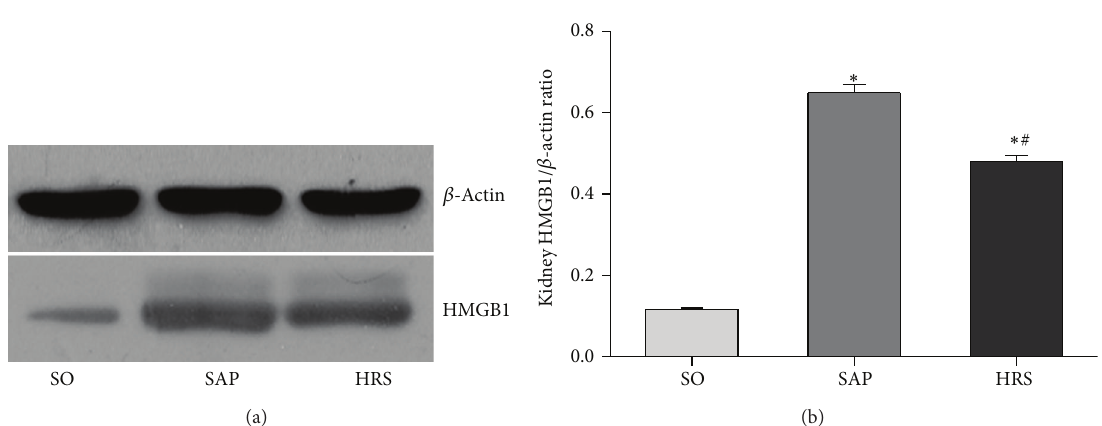
Figure 9: Western blotting for measuring the expression of HMGB1 by using extract of renal total proteins at 24 hours. (a) Level of HMGB1 and (b) densitometric analysis of the bands for the ratio of HMGB1/ 𝛽 -actin. Results are expressed as mean (SD), 8 rats per group. ∗ 𝑃 < 0.05 versus respective SO group; # 𝑃 < 0.05 versus respective SAP